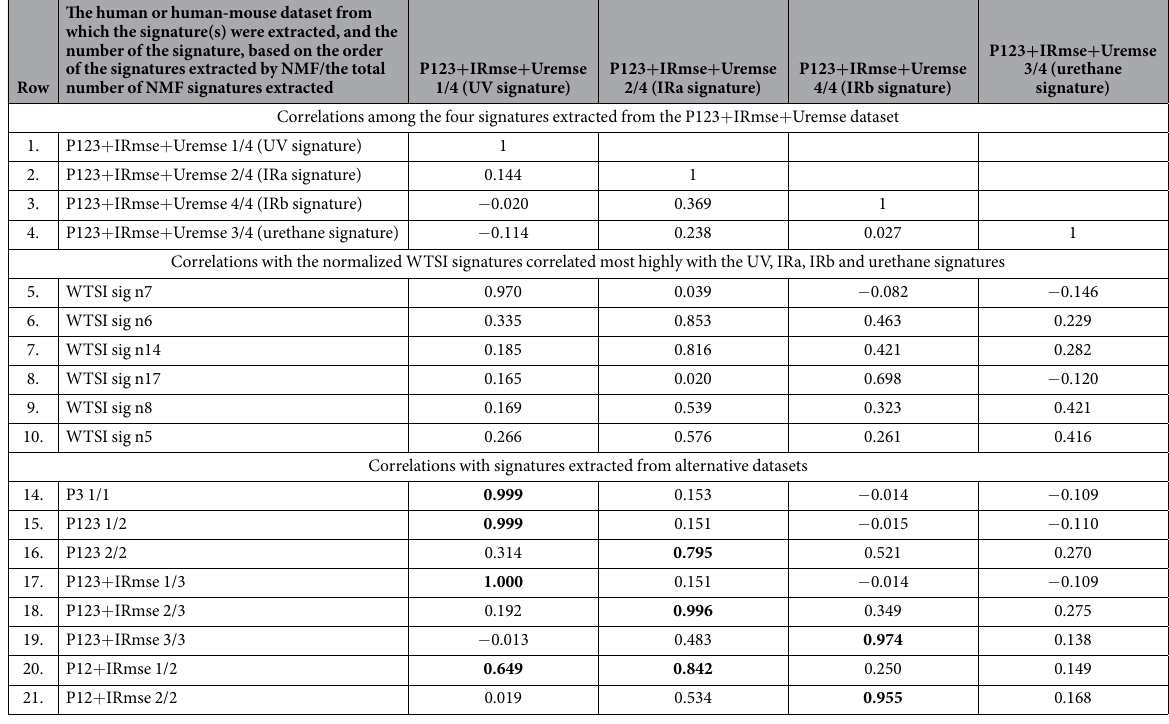
Table 1. Correlations of signature coefficients. We pooled the normalized data for Patients 1, 2 and 3 (the P123 dataset) with the normalized data for the IR-induced mouse malignancies (the IRmse dataset), and with normalized data for 22 samples from urethane-induced mouse malignancies. Correlations with the normalized WTSI signatures correlated most highly with the UV, IRa, IRb and urethane signatures are shown in rows